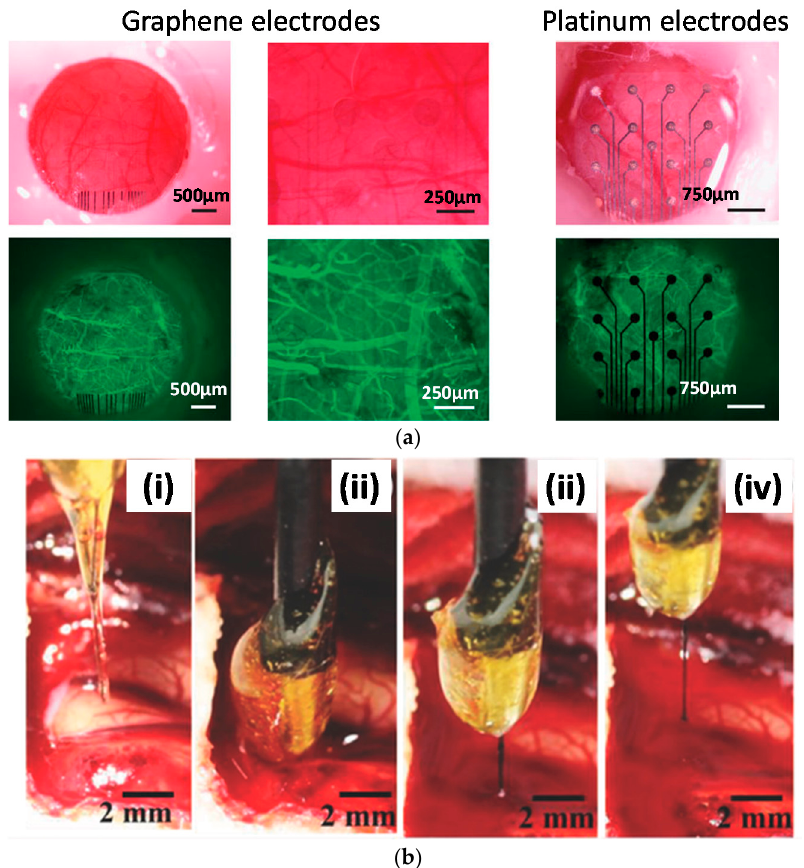
Figure 9. ( a ) Bright-field (top) and fluorescence images (bottom) of semi-transparent graphene-based electrodes (left) compared to platinum electrodes (right); ( b ) Flexible electrode insertion into feline visual cortex. (i) the electrode is coated in a rigid sucrose carrier needle and (ii) implanted into the brain. (iii) and (iv) the electrode is removed from brain after 15 min of recording; sugar needle is completely dissolved. ( a ) Reprinted by permission from Macmillan Publishers Ltd.: Nature Communications